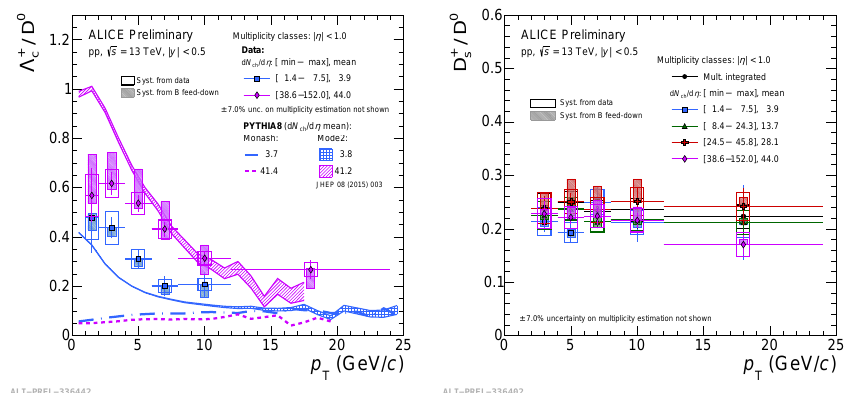
/ D 0 and (right) D + Figure 4: (Left) Λ + c vals versus p measured in pp collisions at T Λ + / D 0 ratios with different PYTHIA8 tunes [ 4,7 ] c